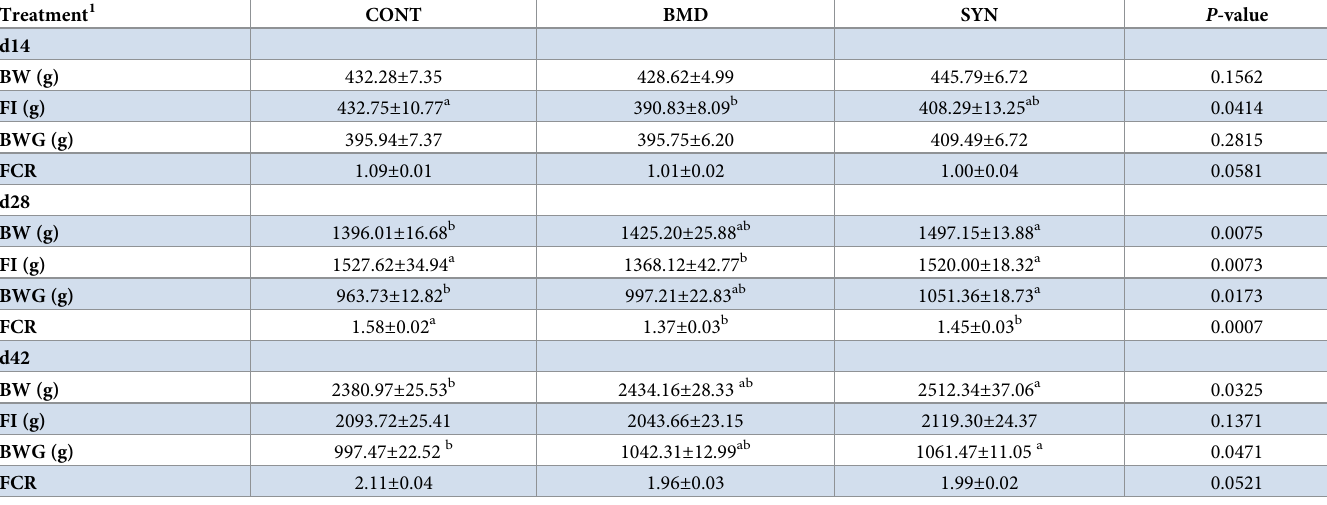
a,b Mean ± SE with different superscripts in the same row differ ( P < 0.05). (n-8 per treatment; and the data were collected from 80 birds/treatment; 10 birds/pen x 8 pens/treatment). 1 CONT, heat stress + a basal diet; BMD, heat stress + the basal diet mixed antibiotic Bactiracin Methylene Disalicylate; SYN, heat stress + the basal diet mixed